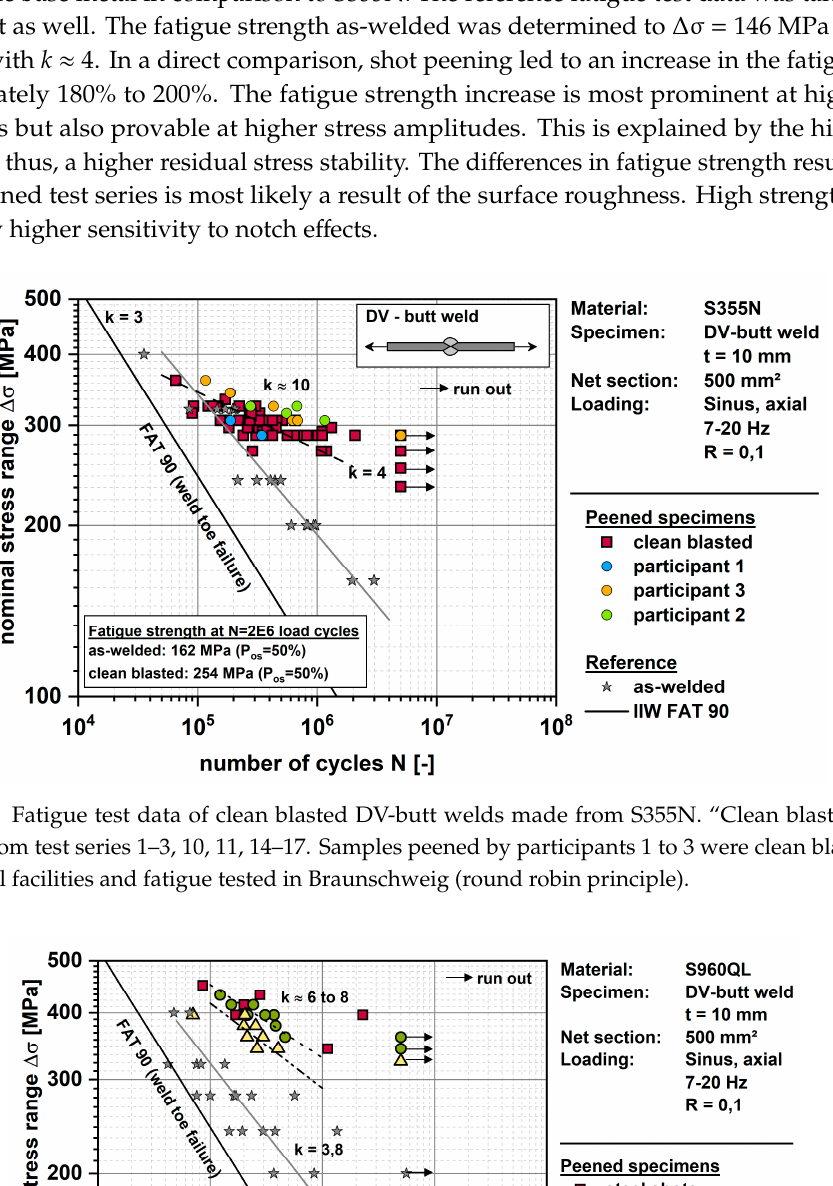
Figure 9. Fatigue test data of clean blasted DV-butt welds made from Al-6082. Shown here are test series 7–8, 12 ,13 and 18–20 named as “clean blasted” without further distinction. 4. Discussion Shot peening generates compressive residual stresses in all three materials. The surface residual stresses vary from test series to test series. Due to distinctive stress gradients, these values are not a good indicator for fatigue benefits through peening. The in-depth compressive residual stress field varies slightly in some of the test series. Steel shots with a coverage of at least 98% led to good penetration depth. However, the fatigue data did not reflect these differences of penetration depth. The peening process appears to be robust in terms of fatigue strength benefits. Nevertheless, the determination of cyclic residual stress relaxation indicates that a full coverage is beneficial for residual stress stability. This in good agreement with the literature [3]. Transferring these results to a possible utilization of clean blasting as a fatigue-enhancing post weld treatment method, full coverage should be always achieved. An explanation for the higher residual stress stability with increasing coverage is the more pronounced cold work hardening. The fatigue data evaluated here (Figure 7 to Figure 9) cannot directly be compared to IIW FAT- values because the data was not corrected for the stress ratio of R = 0.5 (IIW). Furthermore, the data was analyzed based on a 50% probability of survival. This study clearly shows the beneficial effect of shot peening on the fatigue strength of DV-butt welds made from a wide range of construction metals